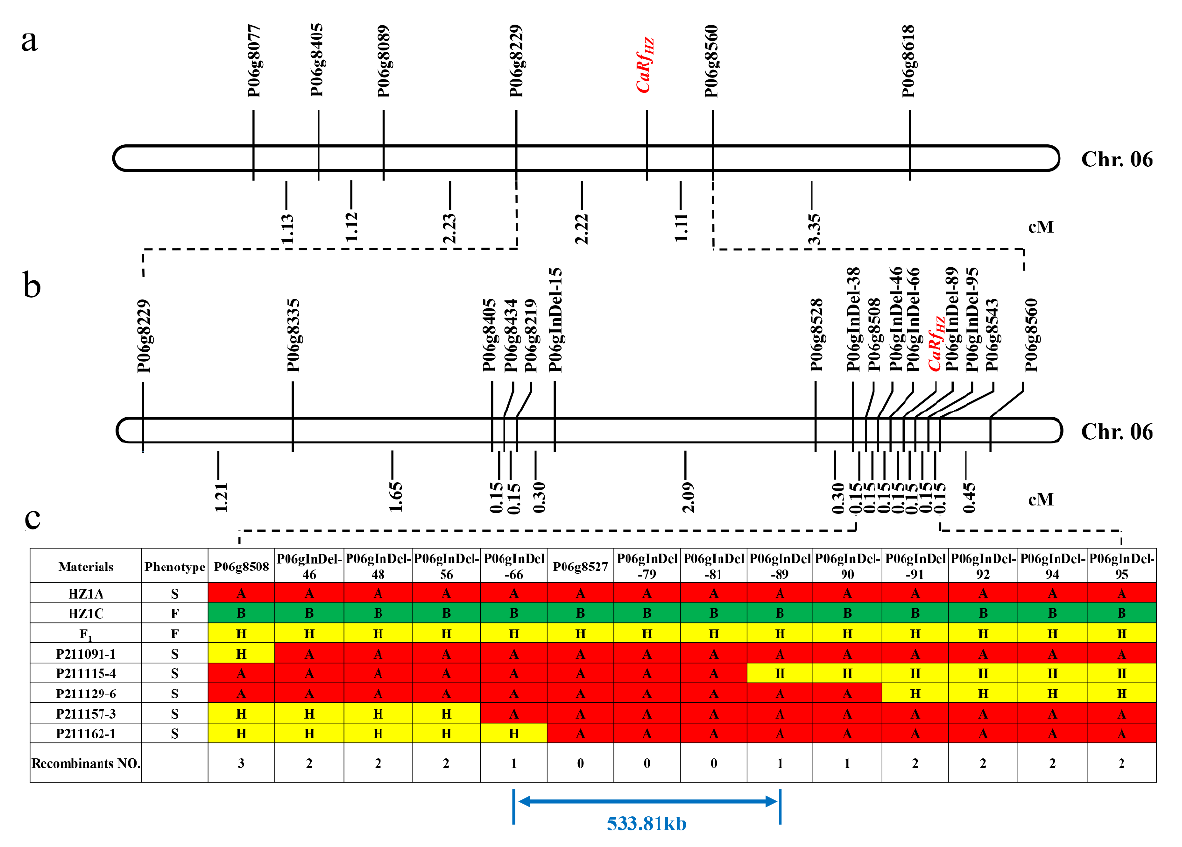
Figure 1. Mapping of the pepper CaRf HZ gene. ( a ) Primary mapping of CaRf HZ using a small popula-